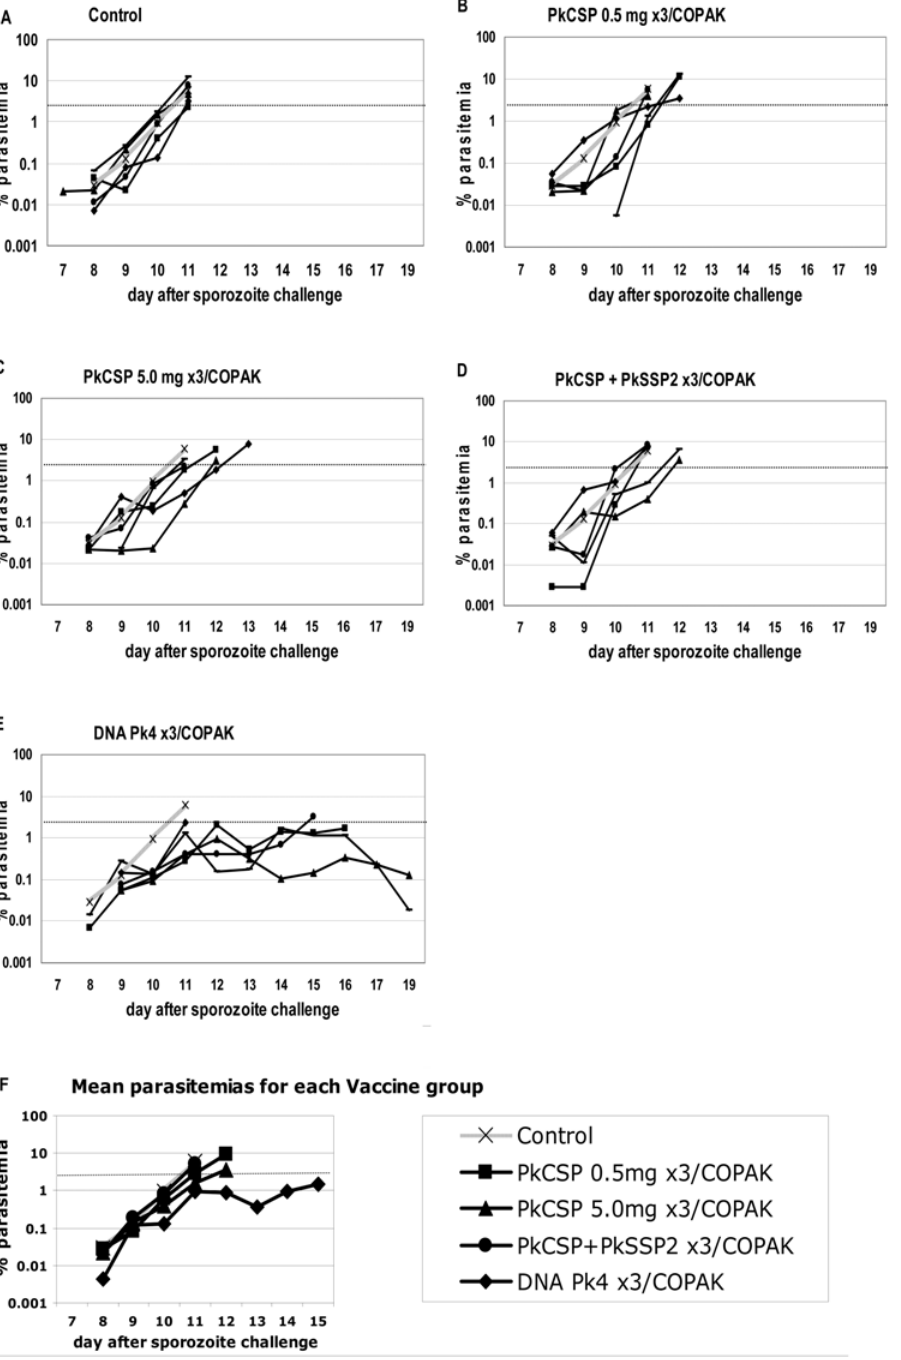
Figure 3. Panels A–E show the % parasitemia for individual monkeys by vaccine group according to the day after sporozoite challenge for Experiment # 2. Data shows the first day parasites were detected and continues until the animal was treated with anti-malarial drugs. For comparison, in each panel the grey line shows the mean parasitemia for the Control group. Panel F shows the geometric mean parasitemias for all the vaccine groups for all days in which at least three animals had not been drug treated.